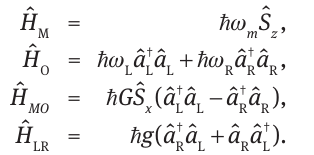
Figure 1B. The main difference of the deformation cavity is the propagation of photons along a straight line before being reflected, whereas the evolution of the system in the phase space is